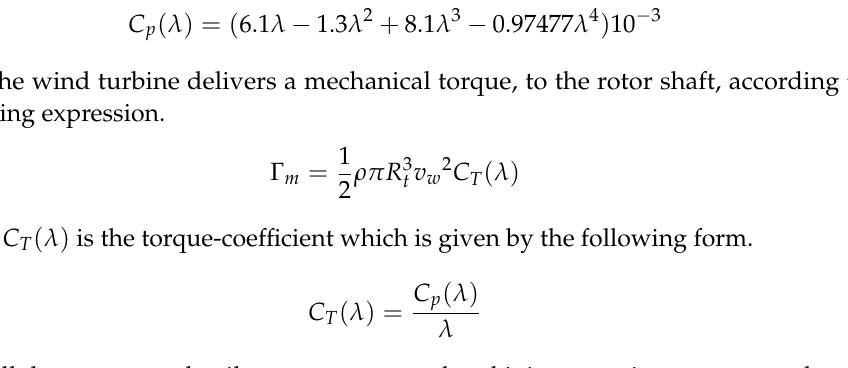
Figure 2. Turbine speed versus turbine power for different wind speeds. The wind-power coefficient C p ( λ ) is a nonlinear function of TSR and pitch angle. It reaches the maximum when the TSR is at the optimum value, known as λ opt . Therefore, a variable-speed wind turbine monitors the C P to extract the maximum power up to the max nominal speed by changing the rotor-shaft speed to keep the system at λ opt